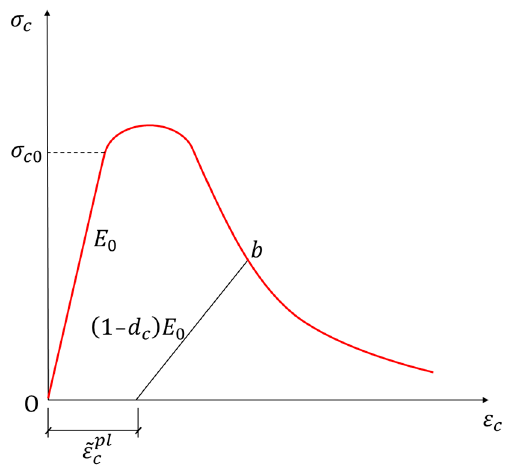
Figure 6. Stress-strain relationship for concrete under uniaxial compression.